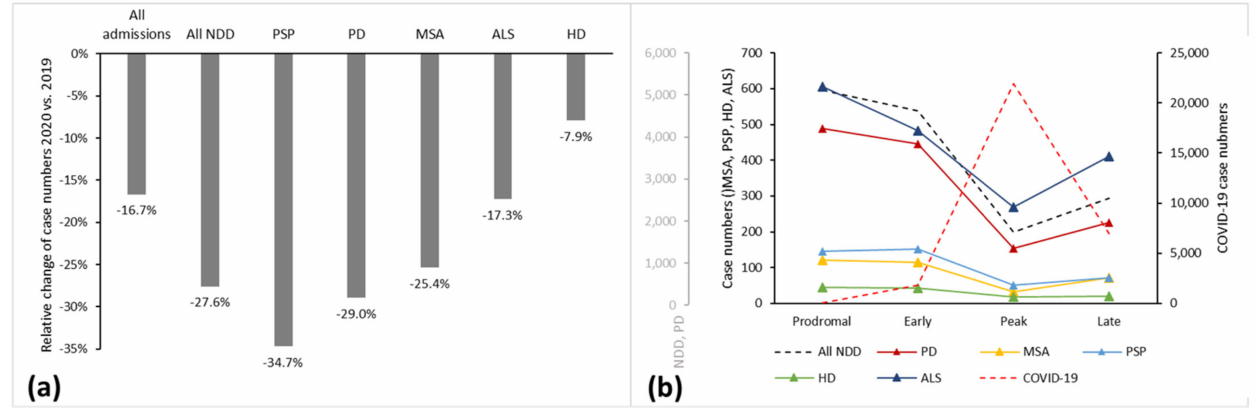
Figure 1. Admission numbers of various neurodegenerative diseases and COVID-19. ( a ) Relative changes 2020 vs. 2019 between January 16 and May 15; ( b ) Absolute count throughout the course of four phases of the first pandemic wave. Table 1. Admission numbers of various neurodegenerative diseases and COVID-19 during the study period in 2020 and 2019, year-to-year and pre/post relative changes between phases of the first wave.